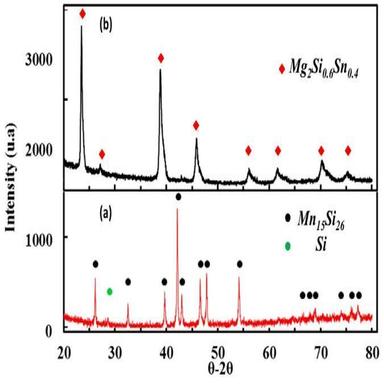
X-ray diffraction patterns for: a) MnSi1.77 and b) Mg2Si0.6Sn0.4.